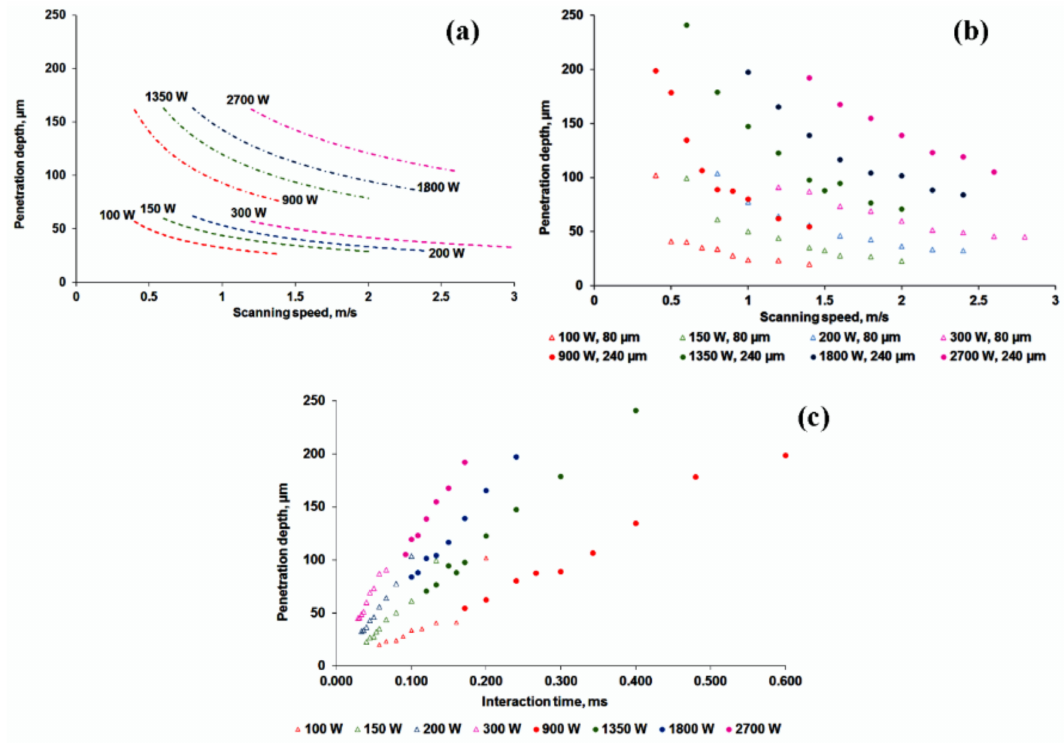
Figure 9. Calculated ( a ) and experimental effect ( b , c ) of scanning speed ( b ) and interaction time ( c ) on the penetration depth at different laser powers and beam diameters.